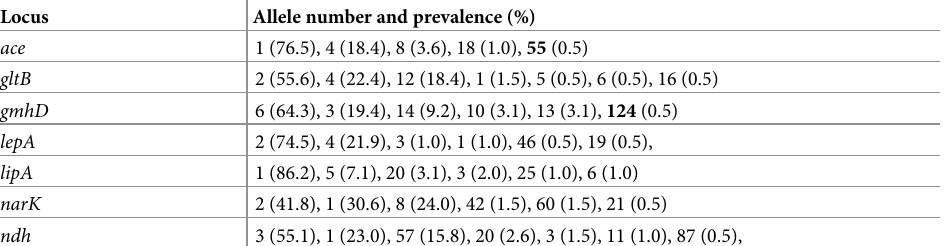
Table 2. Prevalence of alleles in the Sri Lankan population (n = 193) of Burkholderia pseudomallei . Locus Allele number and prevalence